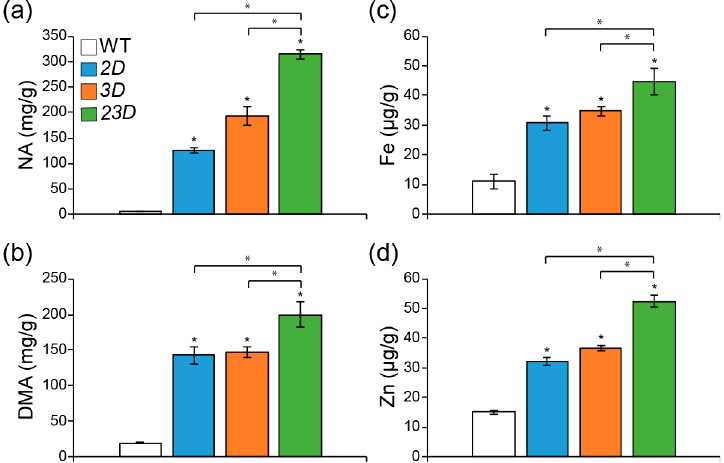
Figure 5. Increment of Fe and Zn concentrations in the mature seeds. Levels of NA ( a ), DMA ( b ), Fe ( c ), and Zn ( d ) in the unpolished seeds from WT and activation-tagged mutants. Data are means ± SE (n = 4), and signi fi cant di ff erences among mutants and WT plants are indicated with an asterisk (* p < 0.05 by Student’s t -test).